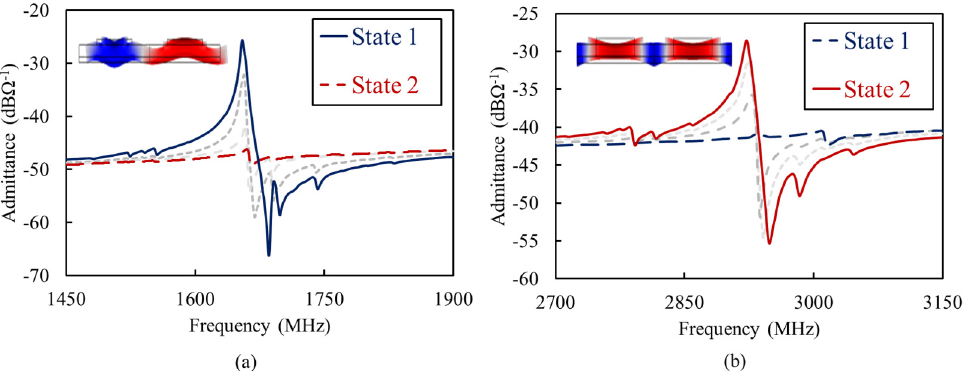
Figure 7. Short − span measured admittance of the Lamb − wave resonator with an IDT pitch size of 2.4 mm when operating in ( a ) State 1 and ( b ) State 2. The intermediate admittance plots, shown in dashed gray line, highlight the transition between the two operation states.